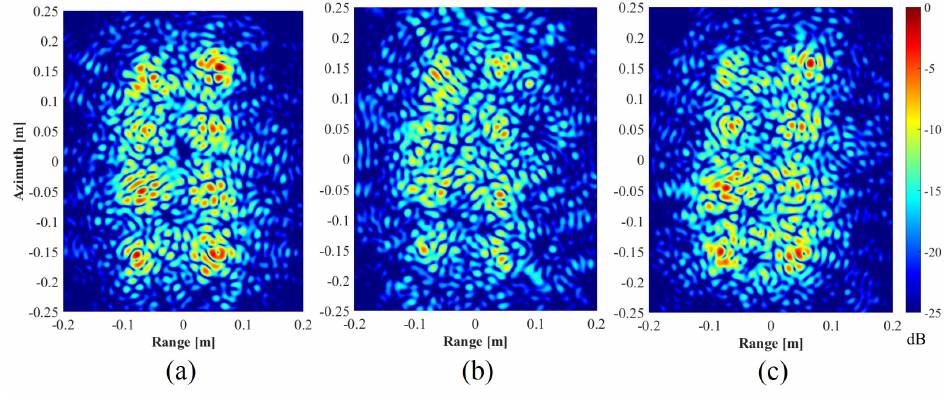
Figure 5. Reconstructed circularly polarized SAR (CP-SAR) images for the rice observed on 30 August 2016. The images are normalized to the maximum value of three images. ( a ) LL polarization; ( b ) RL polarization; ( c ) RR